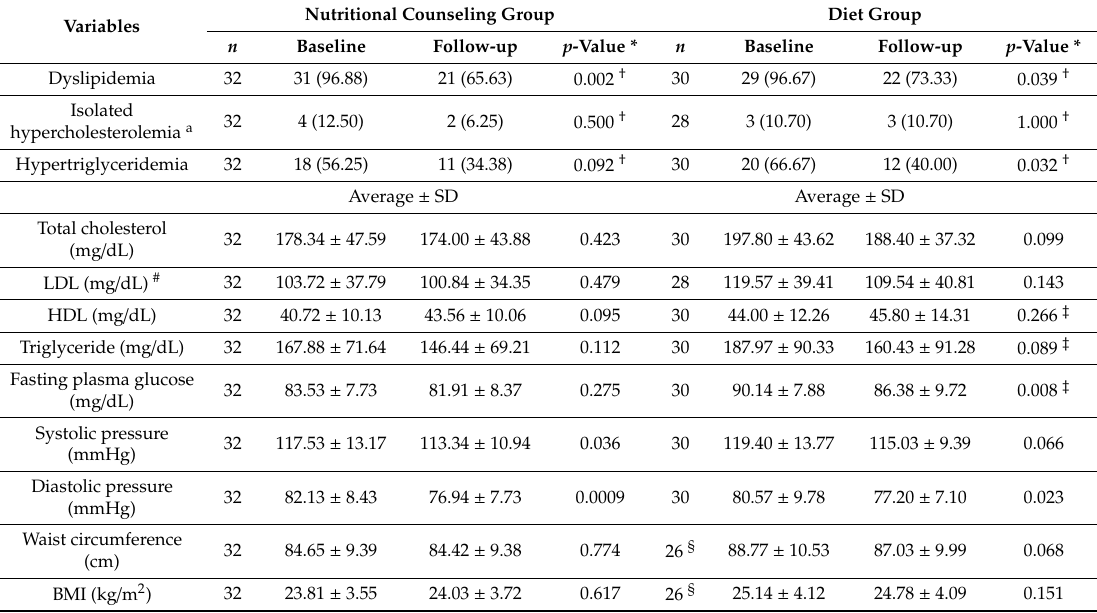
Table 2. Cardiometabolic variables: comparison of baseline data with the end of follow-up for each group of the randomized clinical trial.